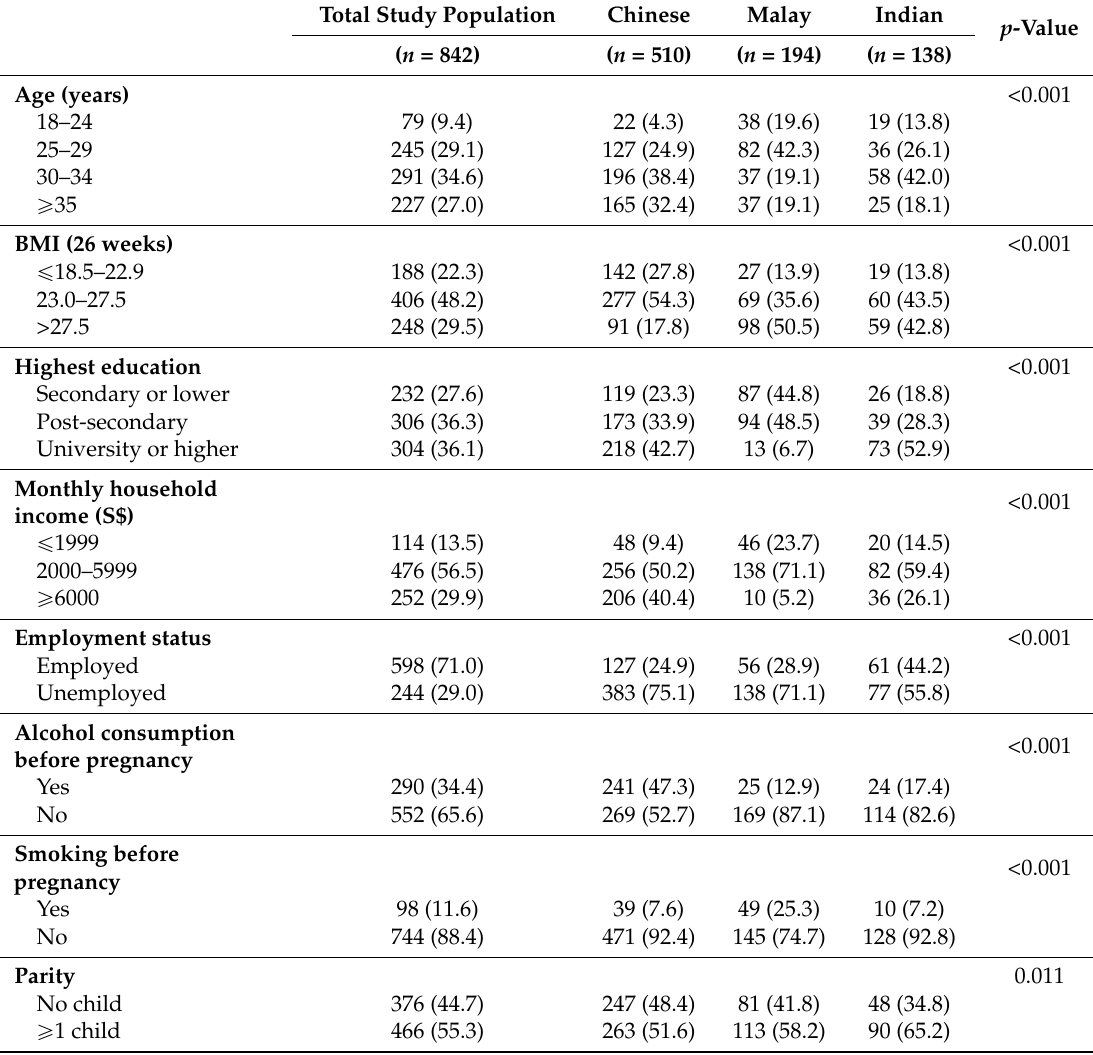
Table 1a. Profile of the mothers in the study ( n (%)).